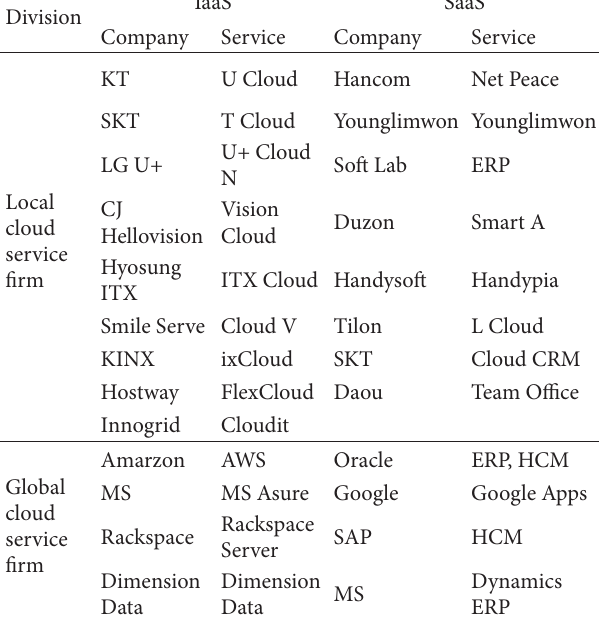
Table 1: Domestic and global cloud services in